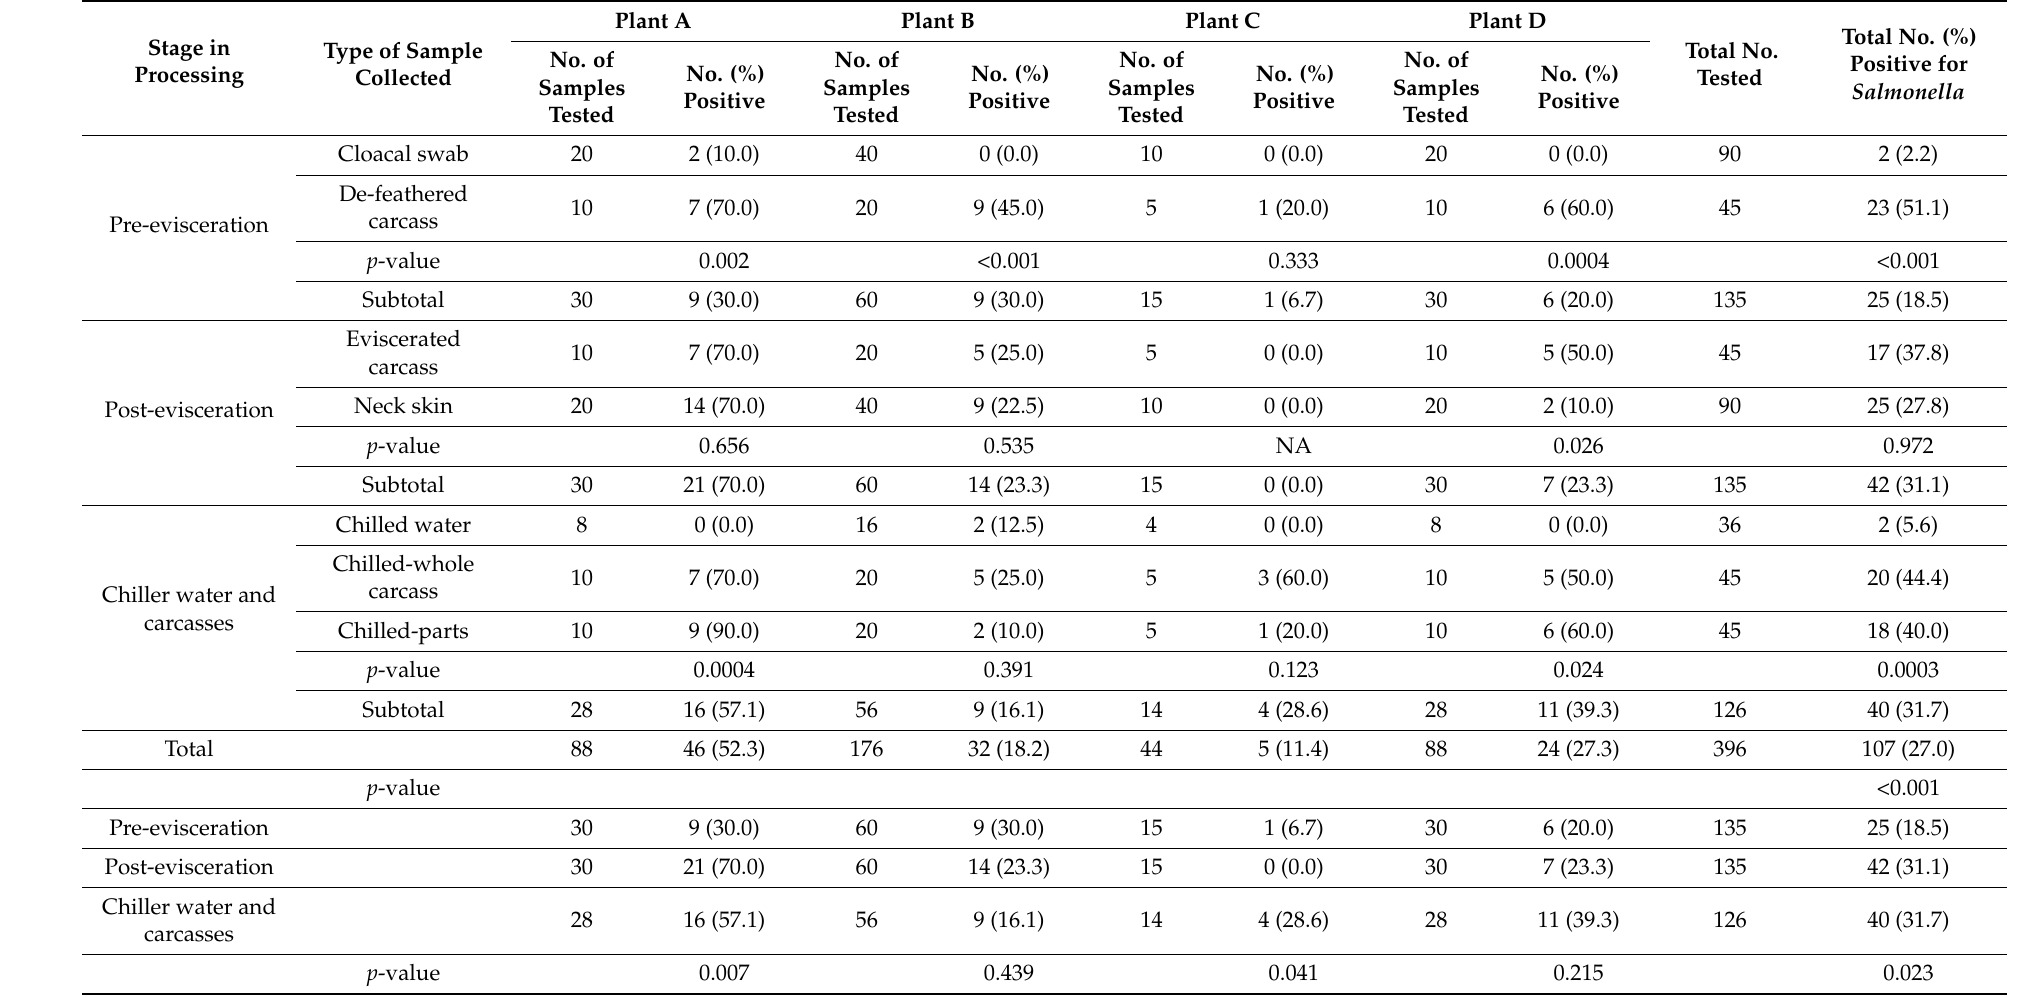
Table 4. Frequency of isolation of Salmonella by type of samples tested at each